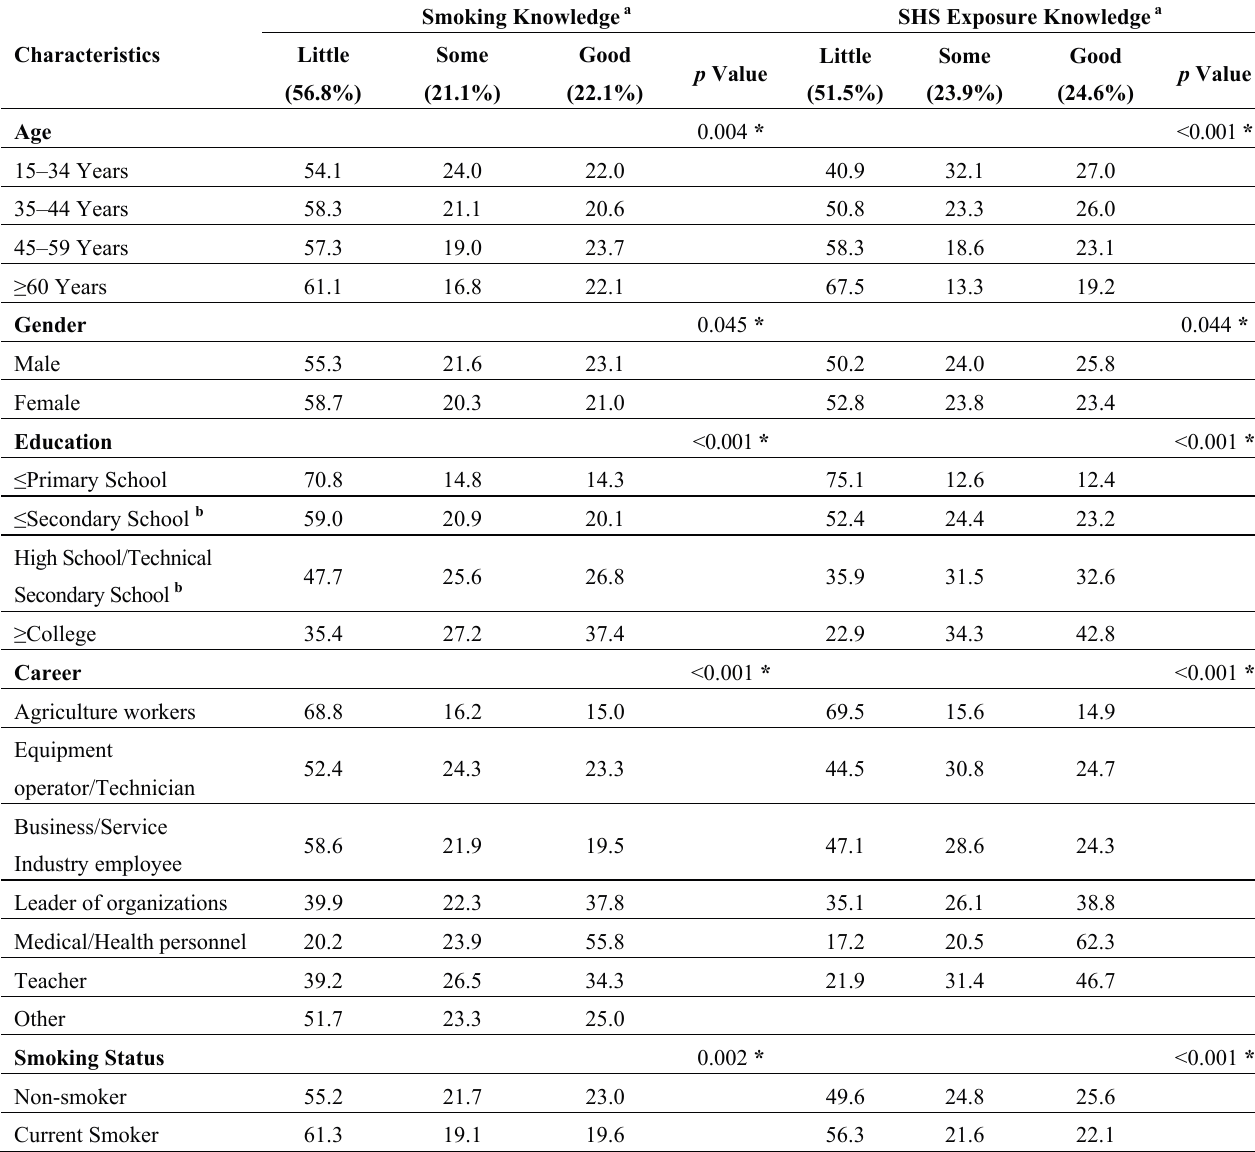
Table 2. Knowledge of harm effects of smoking and SHS